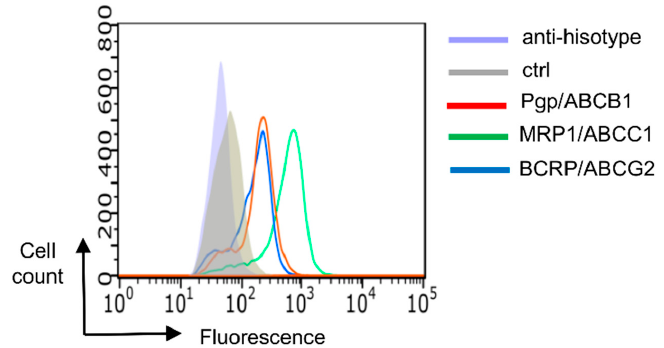
Figure 6. Representative histograms of Pgp/ABCB1, MRP1/ABCC1, and BCRP/ABCG2 surface levels in A375 cells, measured by flow cytometry in duplicate. The figure is representative of 1 out of 3 experiments with similar results.